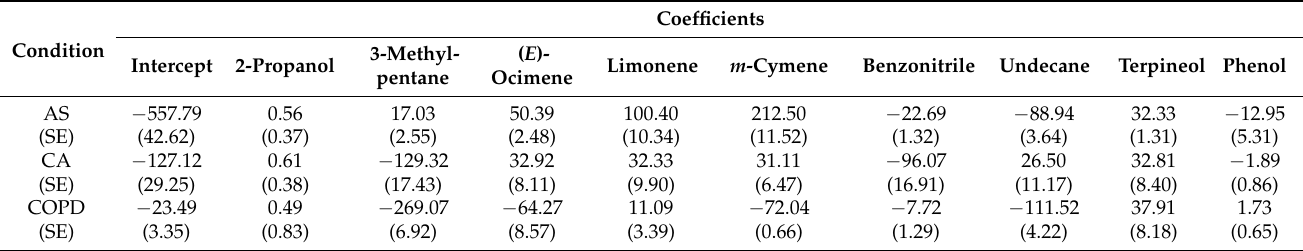
Figure 5. Plot of − (log 10 ) of p values when applying Mann-Whitney test for specific classes: ( a ) lung cancer, ( b ) COPD or ( c ) asthma, against all other conditions. Dashed line represents where p ≤ 0.05. Variables represented by triangle shape icon were those included in MLR final model. Table 3. Description of MLR model (AS = asthma, CA = lung cancer, COPD = chronic obstructive pulmonary disease, SE = standard